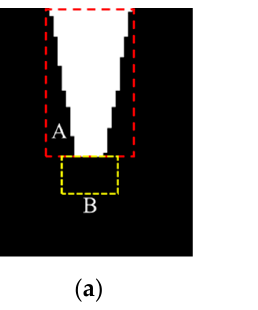
Figure 9. Lost tip data restoration process. ( a ) ROI assignment to the morphological filtered image; ( b ) boundary mapping using straight lines; ( c ) restored tip data image.